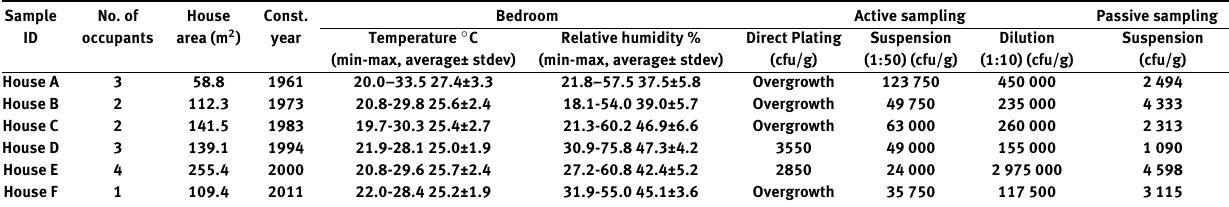
Table 1. Characteristics of the surveyed houses with the indication of: number of occupants, area (m 2 ), construction year (Const. year), tem- perature ( ∘ C) and relative humidity (%) registered in the master bedroom (min-max, average ± stdev) and the number of total Colony Form- ing Units (CFU) using active and passive sampling methods. For the active sampling method, the results are shown for the three different culture techniques used (direct plating, suspension and